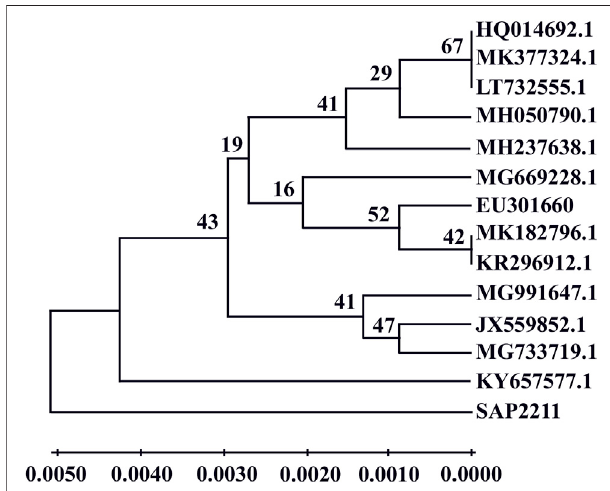
FIGURE 1 | Phylogenetic tree of fungi Aspergillus niger sap